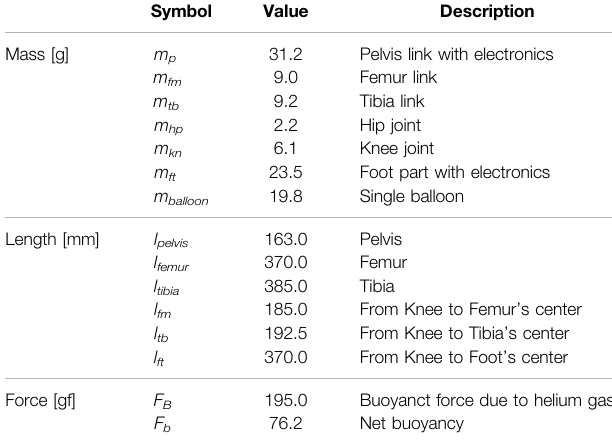
TABLE 1 | Design parameters.